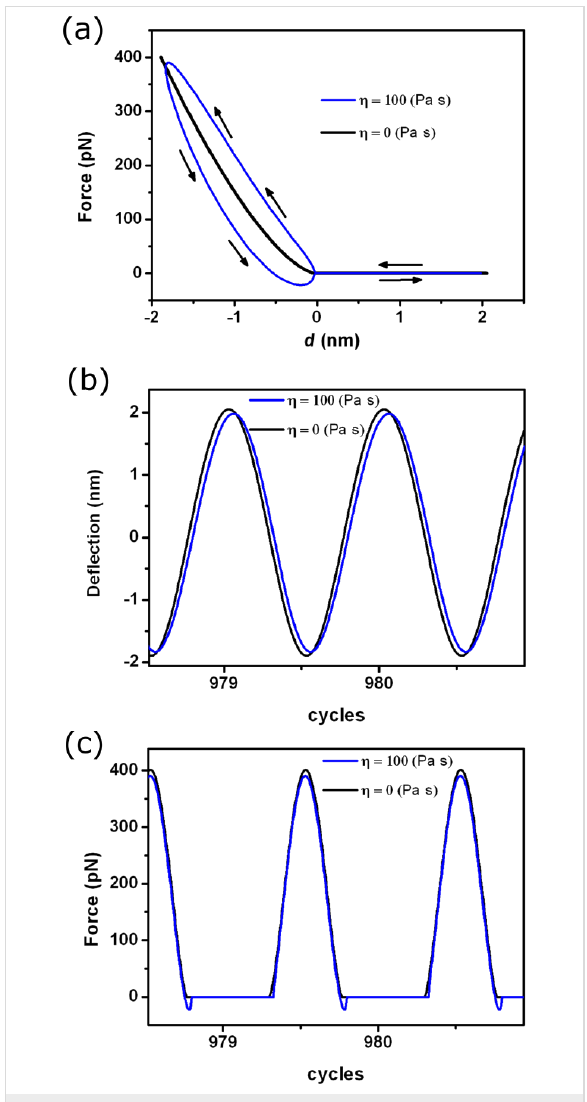
Figure 5: AM-AFM simulations for a viscoelastic material. (a) Force–distance curve for the linear viscous model. The blue curve represents the conservative force given by the Hertz model. (b) Tip deflection as a function of time for an elastic and a viscoelastic ma- terial. (c) Instantaneous force at z c = 0.2